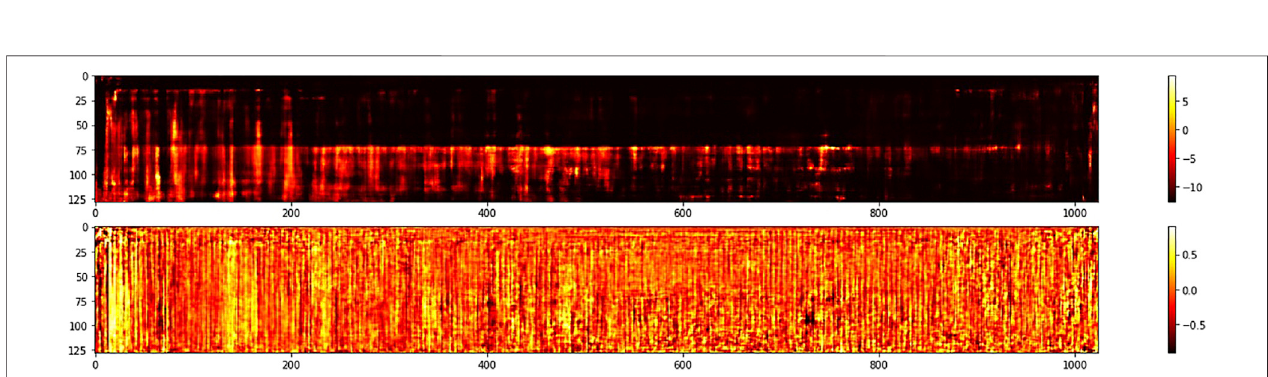
FIGURE4| Threedimensionallatentspacerepresentationoftheinputdataset.Left:Chordscoloredbyvolume(forte,mesoforte,andpiano).Right:chordscolored by base notes. It can be appreciated that the latent space is segmented based on relevant musical properties.